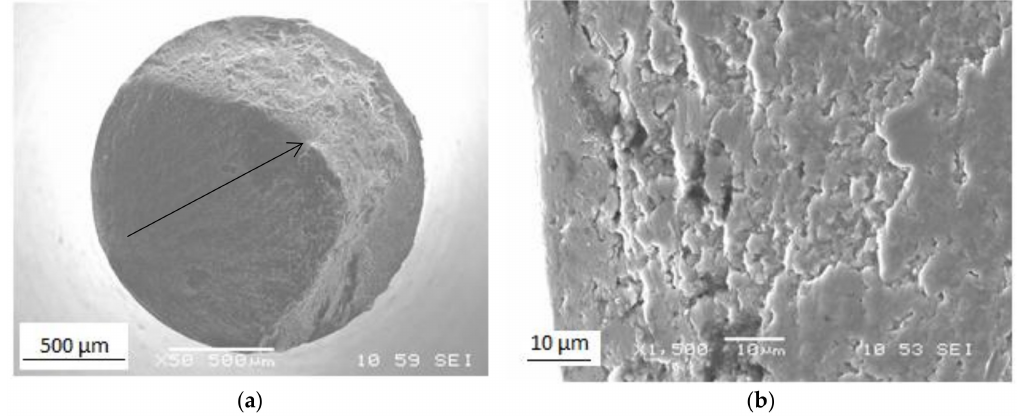
Figure 9. Fracture surface of the sample (Conform SPD one pass + rotary swaging (80% area reduction)) after ( a ) fatigue testing and ( b ) fracture initiation